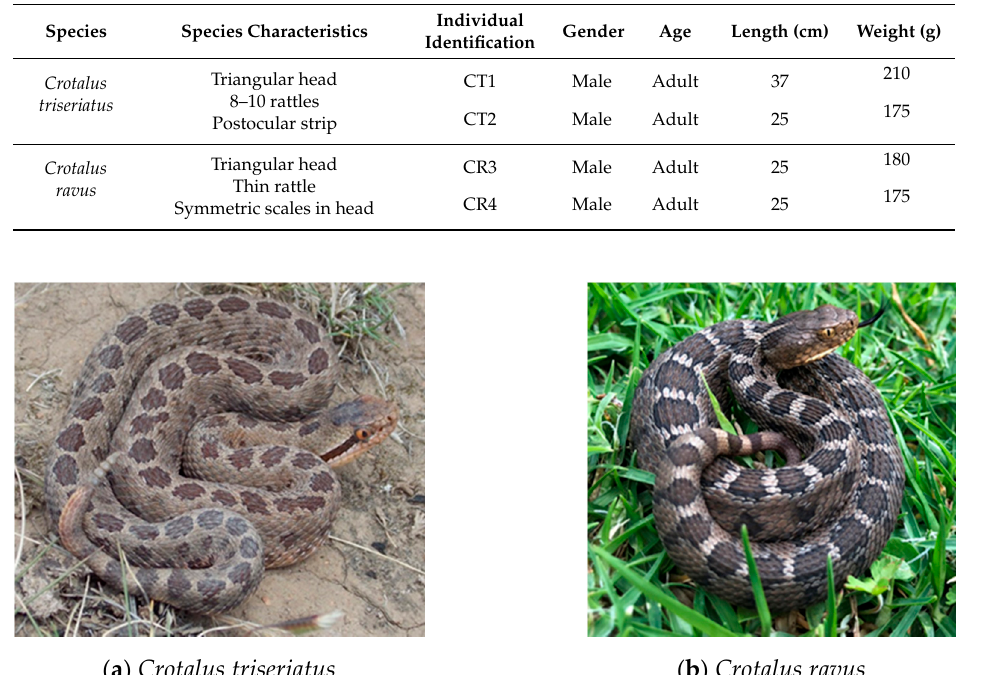
Table 1. Individual data of trapped rattlesnakes in Hidalgo State.